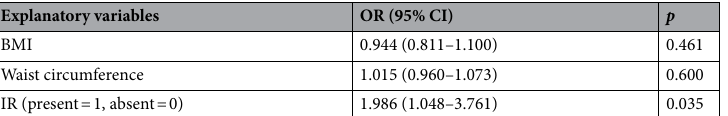
Table 4. Multivariable logistic regression analysis regarding increase in plasma XOR activity over 12-month period. The multivariable logistic regression model used for analysis of increase in plasma XOR activity over a 12-month period included age, sex, alcohol drinking habit, smoking habit, ALT, HbA1c, eGFR, and plasma XOR activity, as well as BMI, waist circumference, and presence of IR at baseline as covariates. BMI body mass index, IR insulin resistance, ALT alanine aminotransferase, HbA1c glycated hemoglobin, eGFR estimated glomerular filtration rate, XOR xanthine oxidoreductase, OR odds ratio, CI confidence